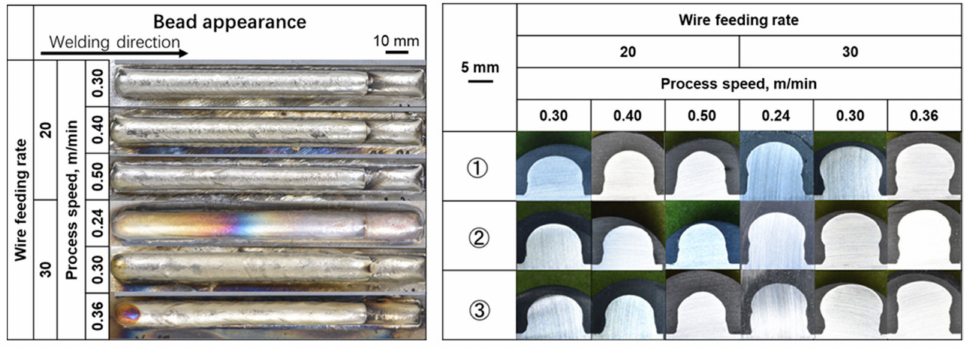
Figure 19. Bead appearances and cross-sections ( P = 5.5